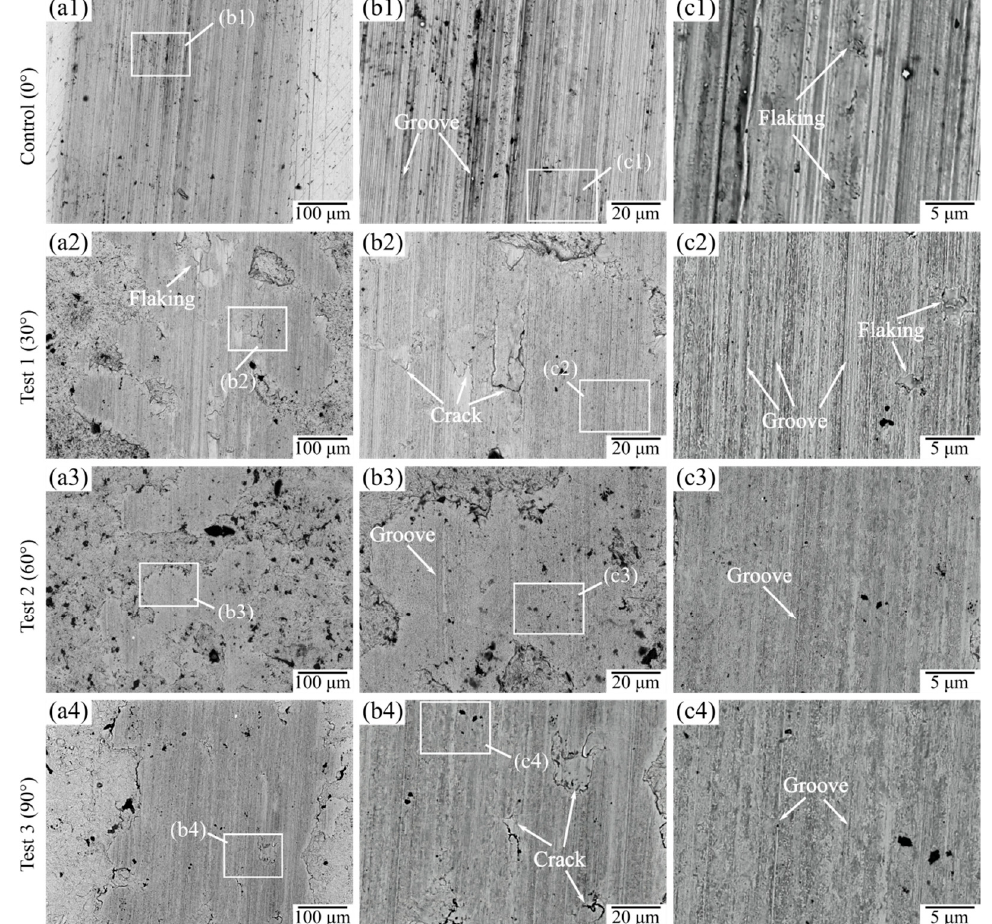
Figure 12. SEM images of worn surface morphology under different jet angles.